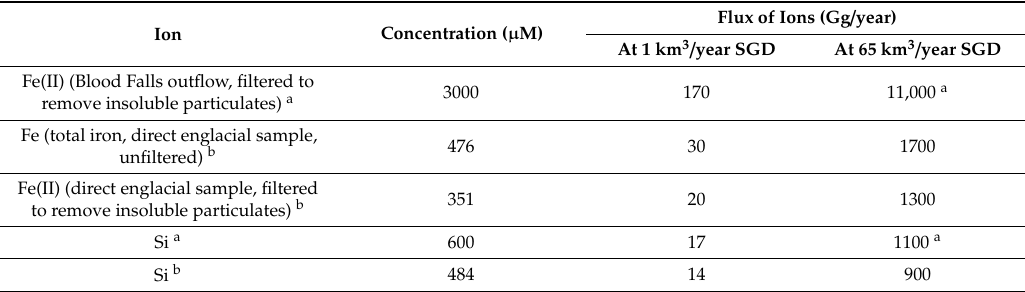
Table 1. Estimated fluxes of Fe and Si through continent-wide SGD, after Table 2 from [21]. Sources: Reported concentrations and calculated values from fields marked (a) are from Reference [21]; concentrations from fields marked (b) are from Reference [26] and the unmarked calculated values are scaled after Table 2 from Reference [21]. [21] cites and slightly rounds its Fe concentrations from Reference [25] and its Si concentrations from References